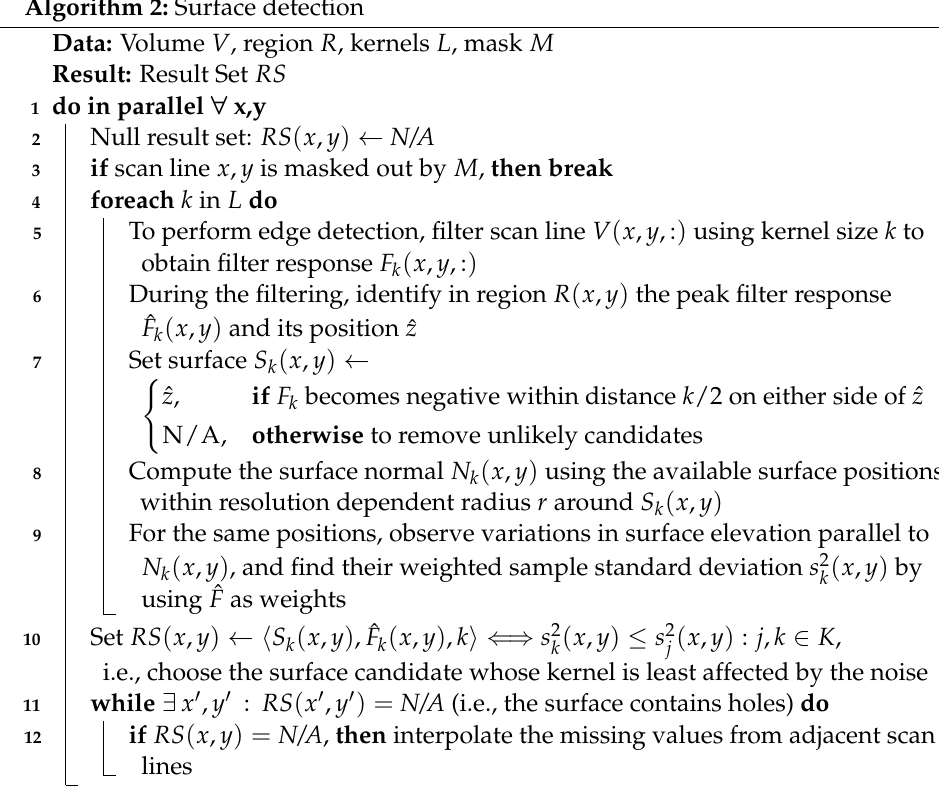
Algorithm 2: Surface